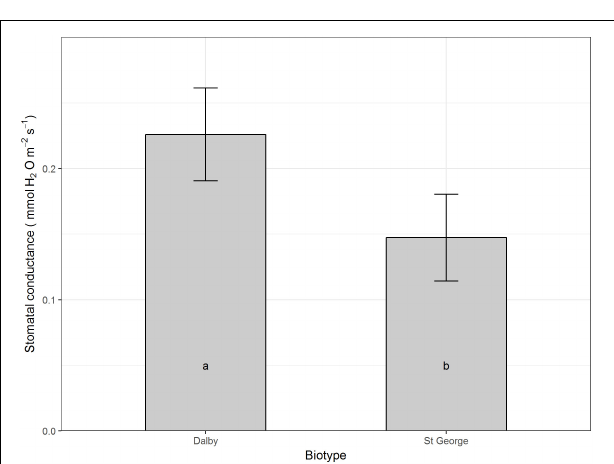
FIGURE 4 | Stomatal conductance (mol H 2 O m - 2 s - 1 ) of rosette leaves of two Australian biotypes (St. George and Dalby) of Sisymbrium thellungii. There were no significant interactions between biotype and water regime so data shown are means for each biotype across all treatments predicted from the linear mixed model. Vertical lines represent standard error and letters within columns indicate whether differences were significant at α = 0.5.